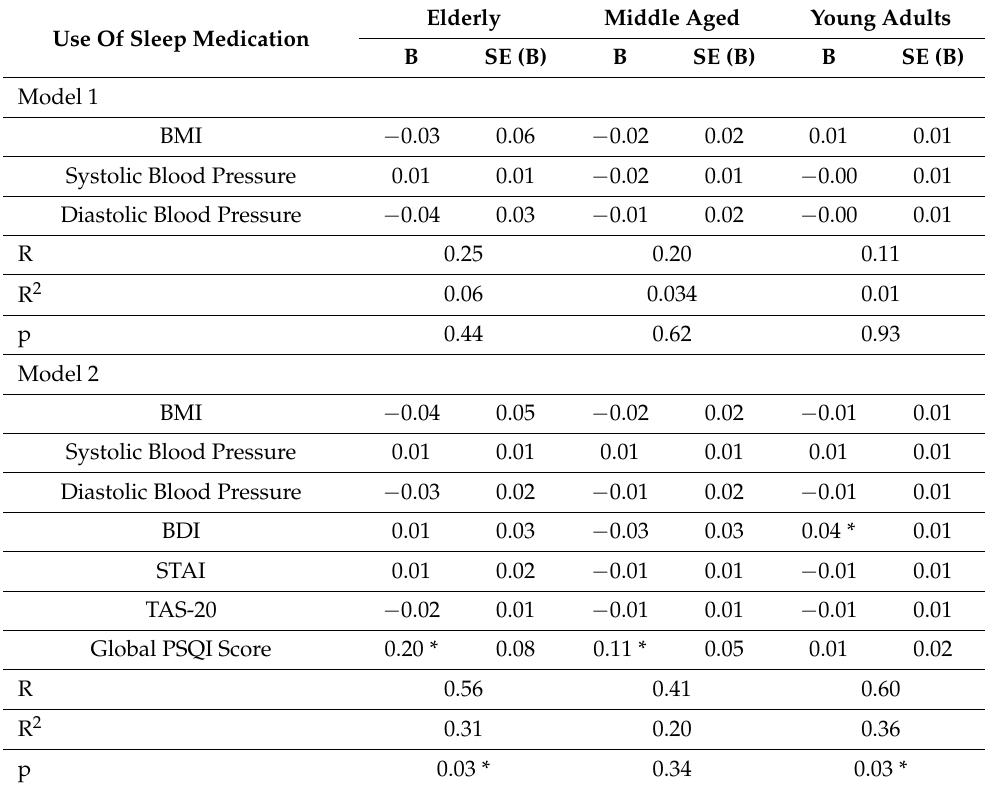
Table 7. Linear regression on use of sleep medication. Use Of Sleep